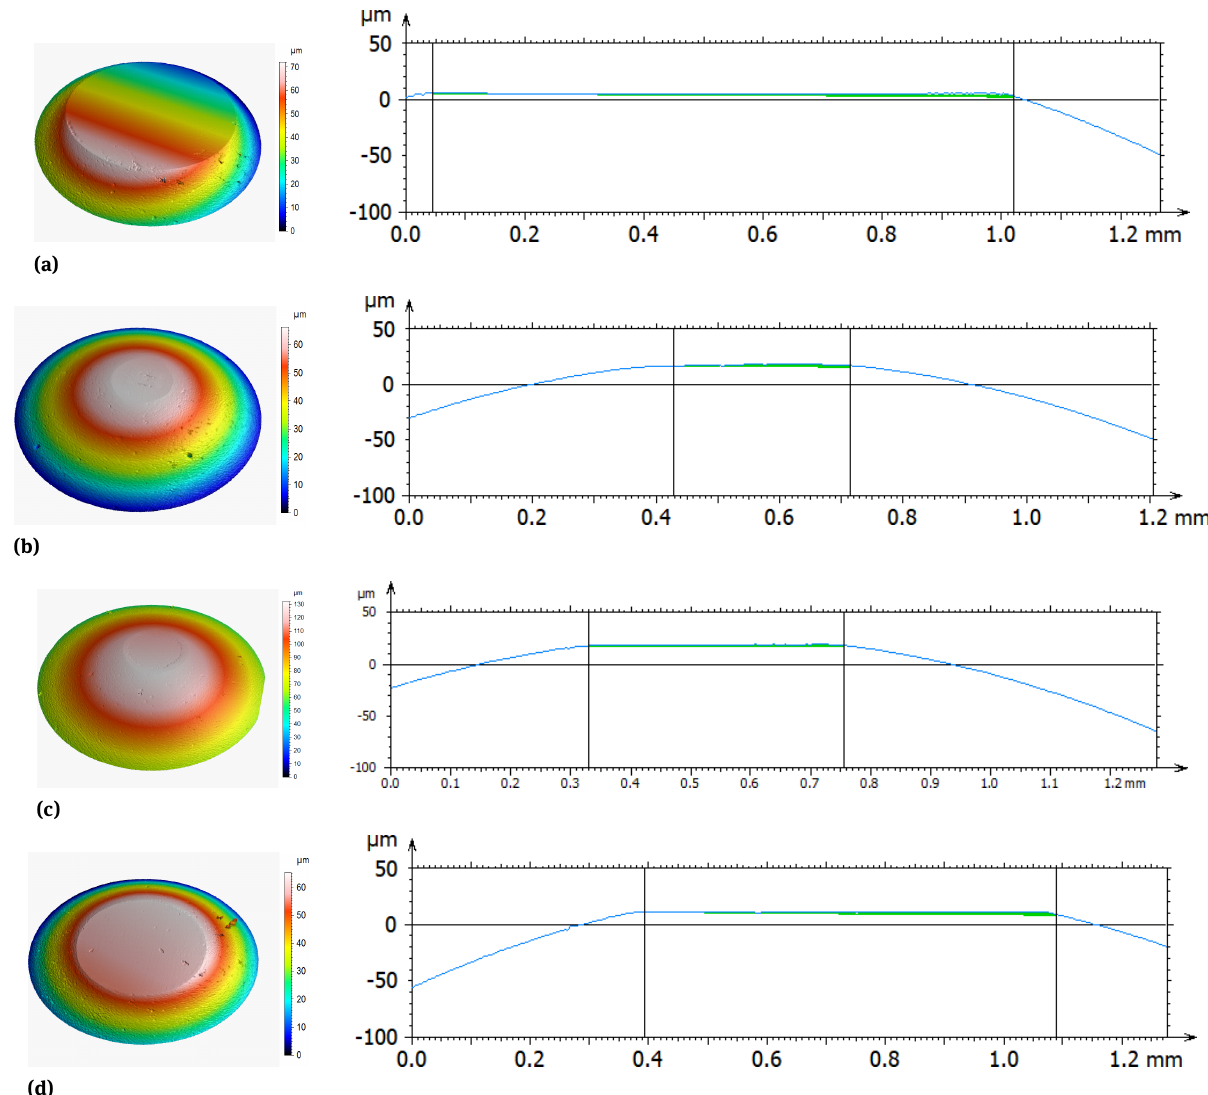
Figure 7: Isometric image and primary profile balls after tribological tests in the following conditions: a) TDS, b) IL1 lubrication, c) IL2 lubrication, d) BCCS